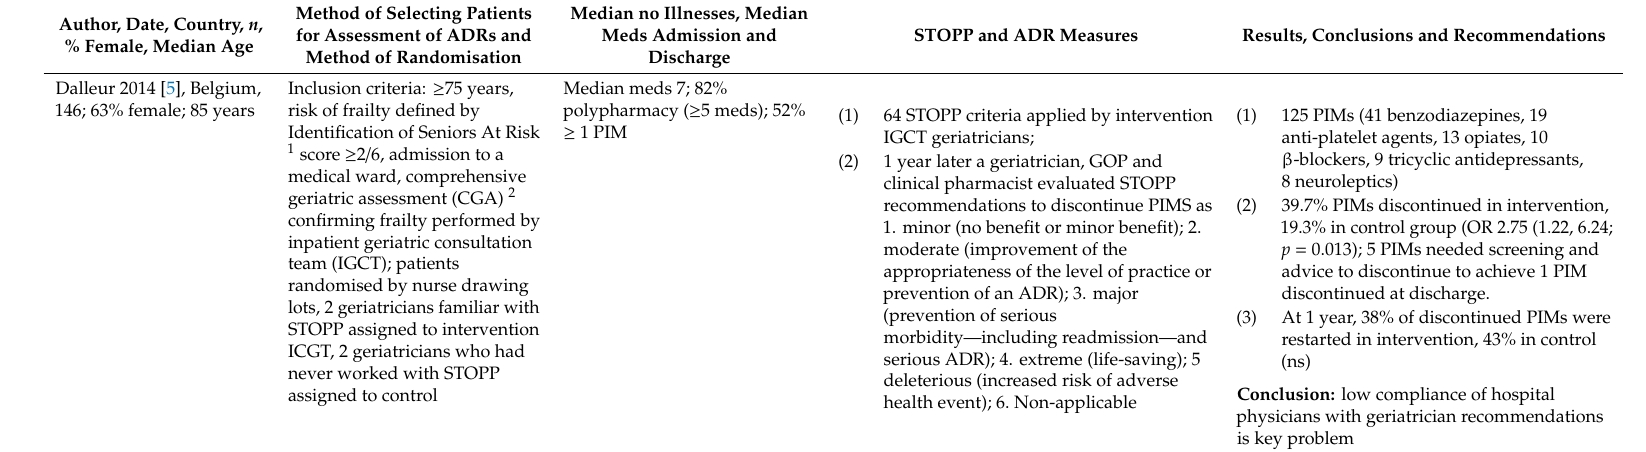
Table 1. Randomised controlled trials of assessing Screening Tool of Older People’s Prescriptions (STOPP) potentially inappropriate medications (PIMs), START potential medication omissions (PPOs), and adverse drug reactions (ADRs) in older hospitalised